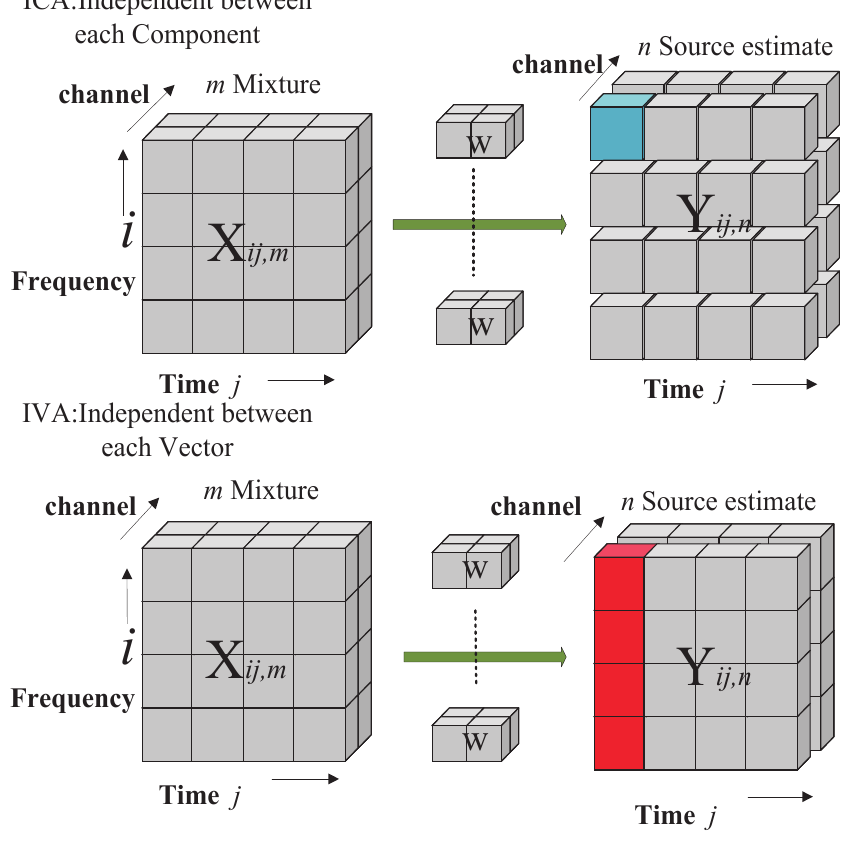
Figure 4. Models of ICA and